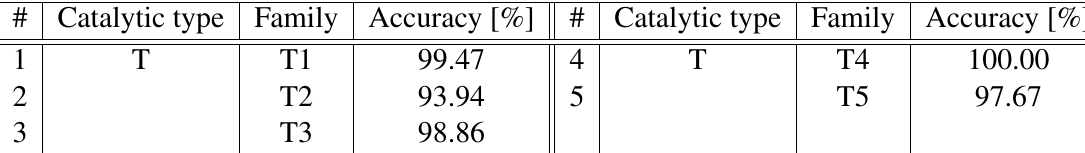
Table 12: Accuracy values for the SVM system and PSI-BLAST.